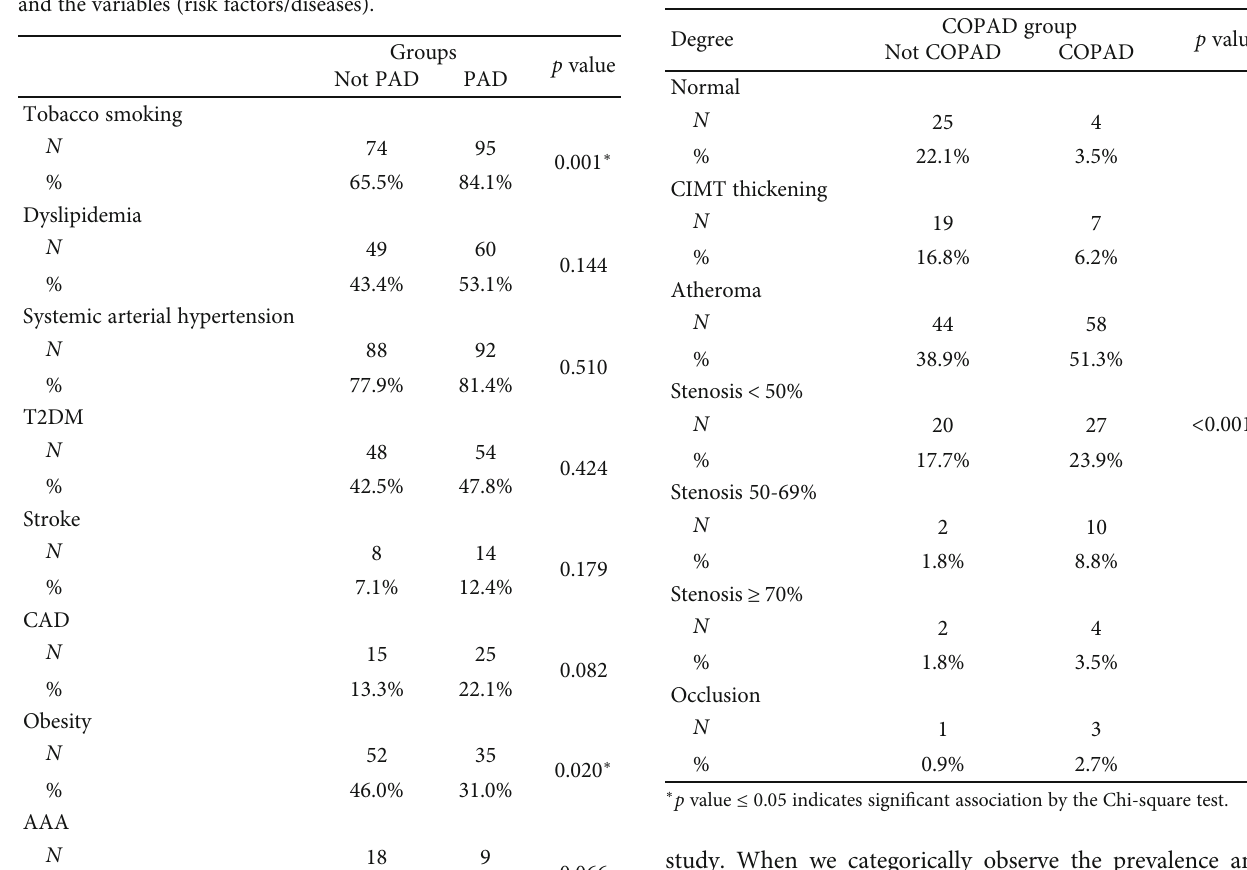
Table 3: Association between PAD and carotid stenosis